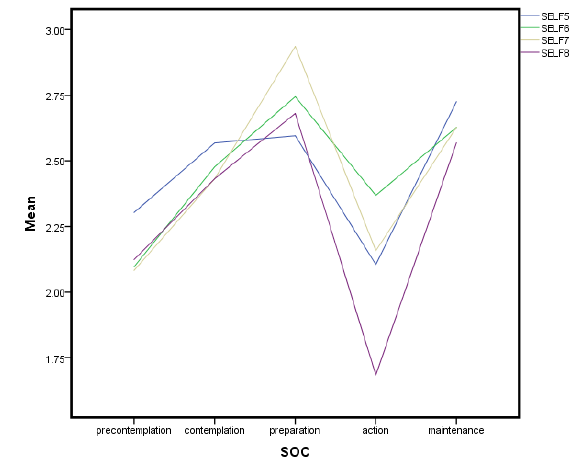
Figure 2 . comparing score of DB1 (wearing a helmet is a good choice), DB2 (smart riders wear helmets), DB3 (helmet decreases head injuries), DB4 (Helmet protects me on roads shared with cars), and DB5 (I feel safer when I wear a helmet while riding a motorcycle) across different stages of change.